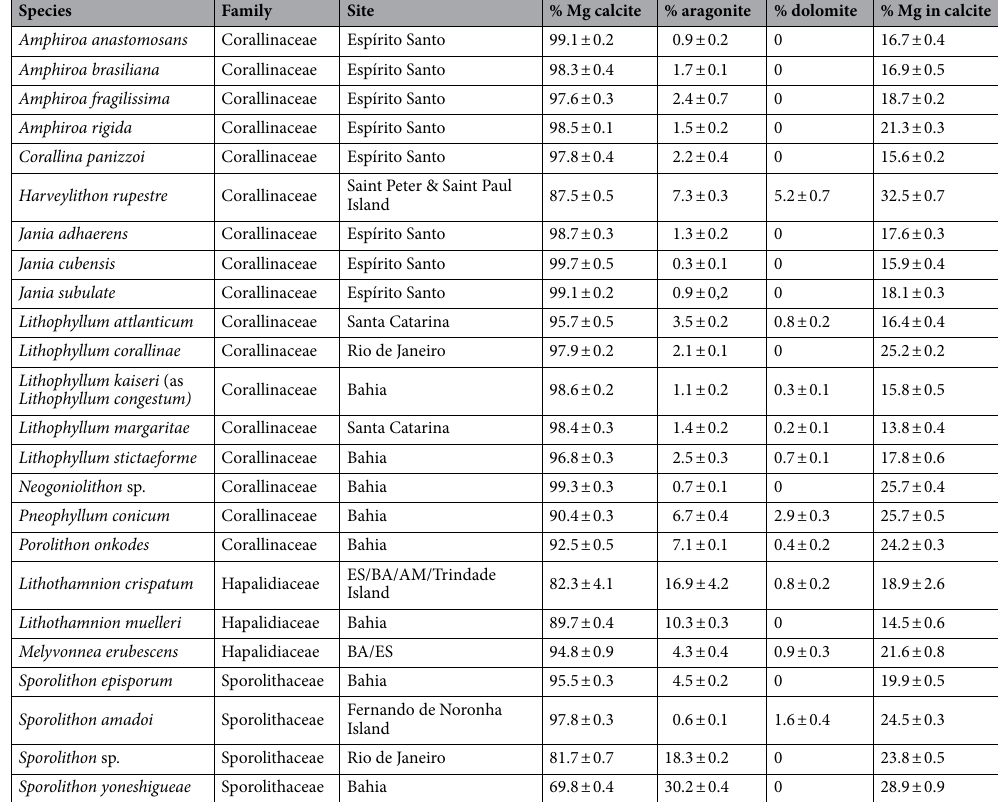
Table 1. Mineralogy (mean percentage ± standard deviation) of coralline algae species collected in several sites along the Brazilian shelf. BA Bahia State, ES Espírito Santo State, AM Amazonas